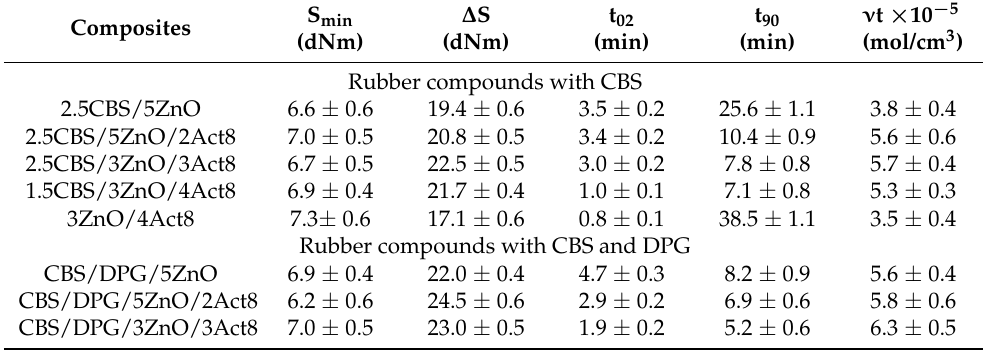
Table 2. Curing characteristics of the SBR compounds at 160 ◦ C and the crosslink density of the vulcan- izates determined using the equilibrium swelling in toluene (S min , minimum torque; S max , maximum torque; ∆ S, torque increase; t 02 , scorch time; t 90 , optimal vulcanization time; ν t, crosslink